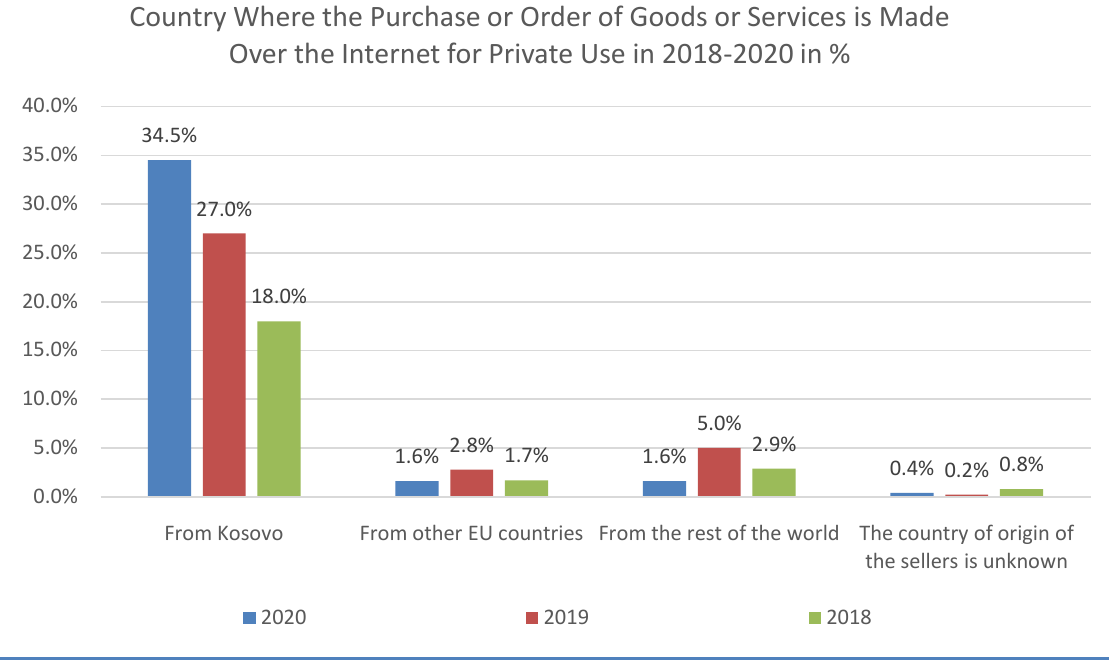
Figure 2: Buying or Ordering Any Goods and Services for Private Use Over the Internet in the Last 12 Months (Source: KAS 2020,